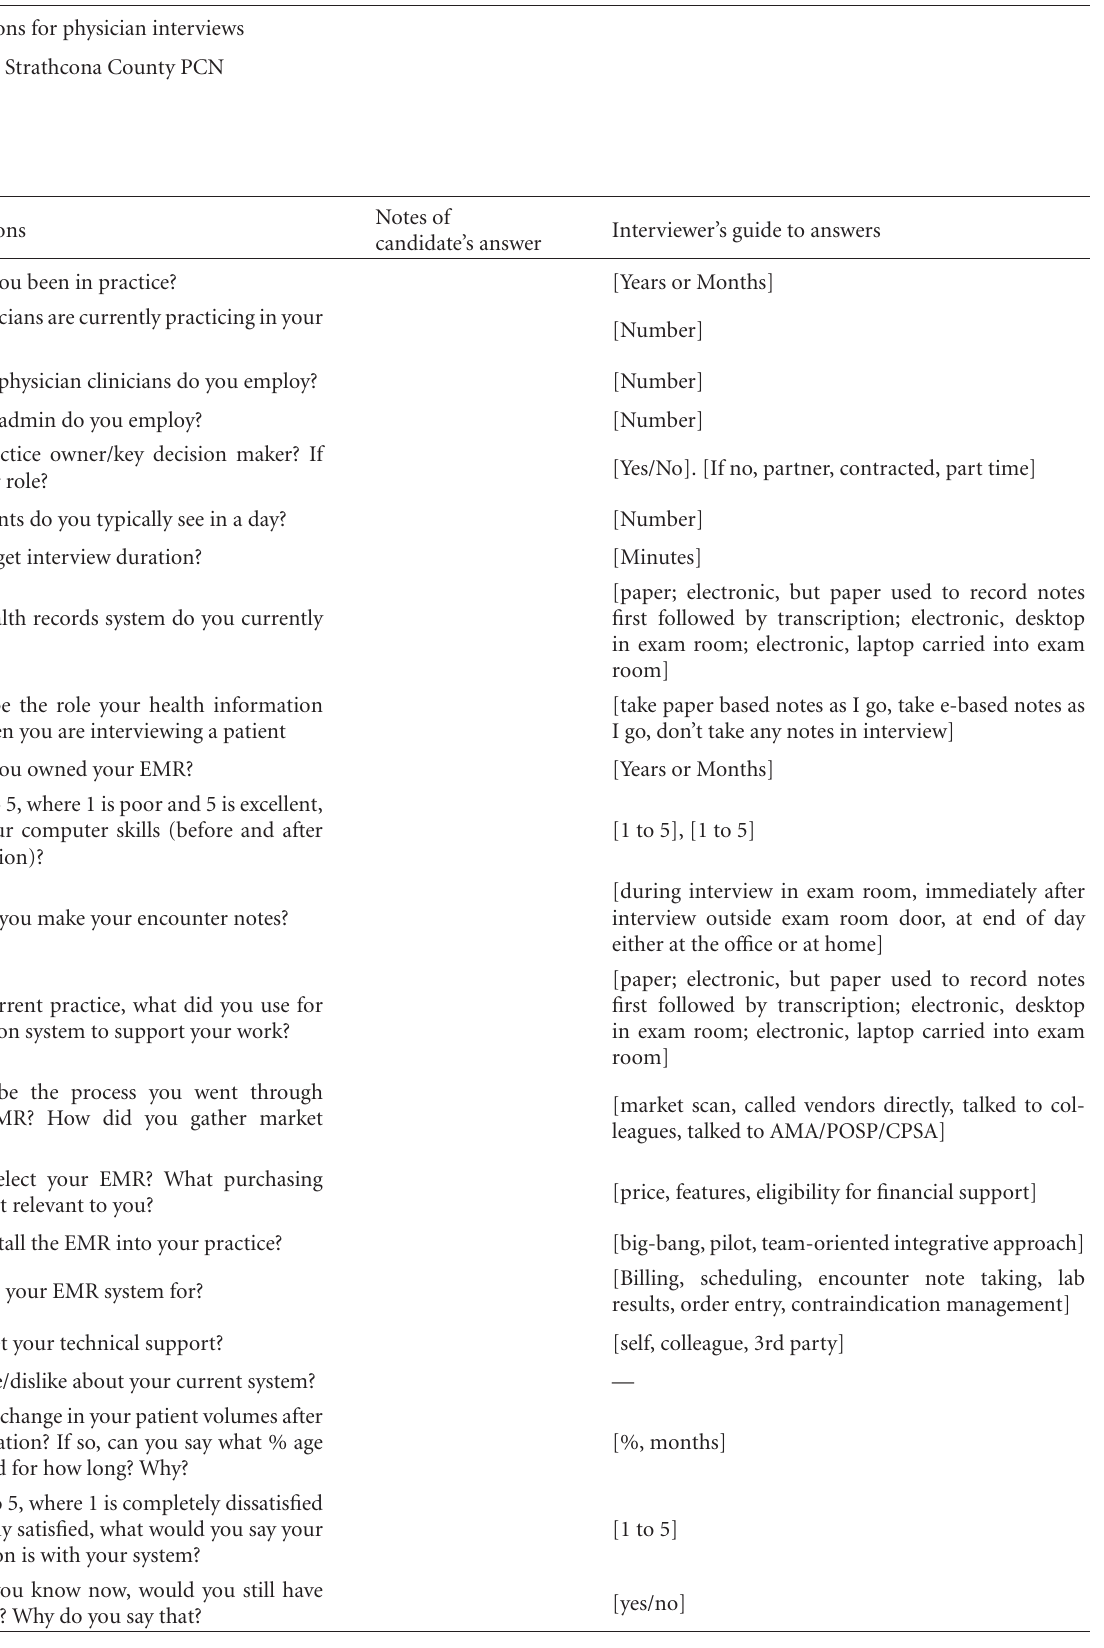
Table 1: Interview